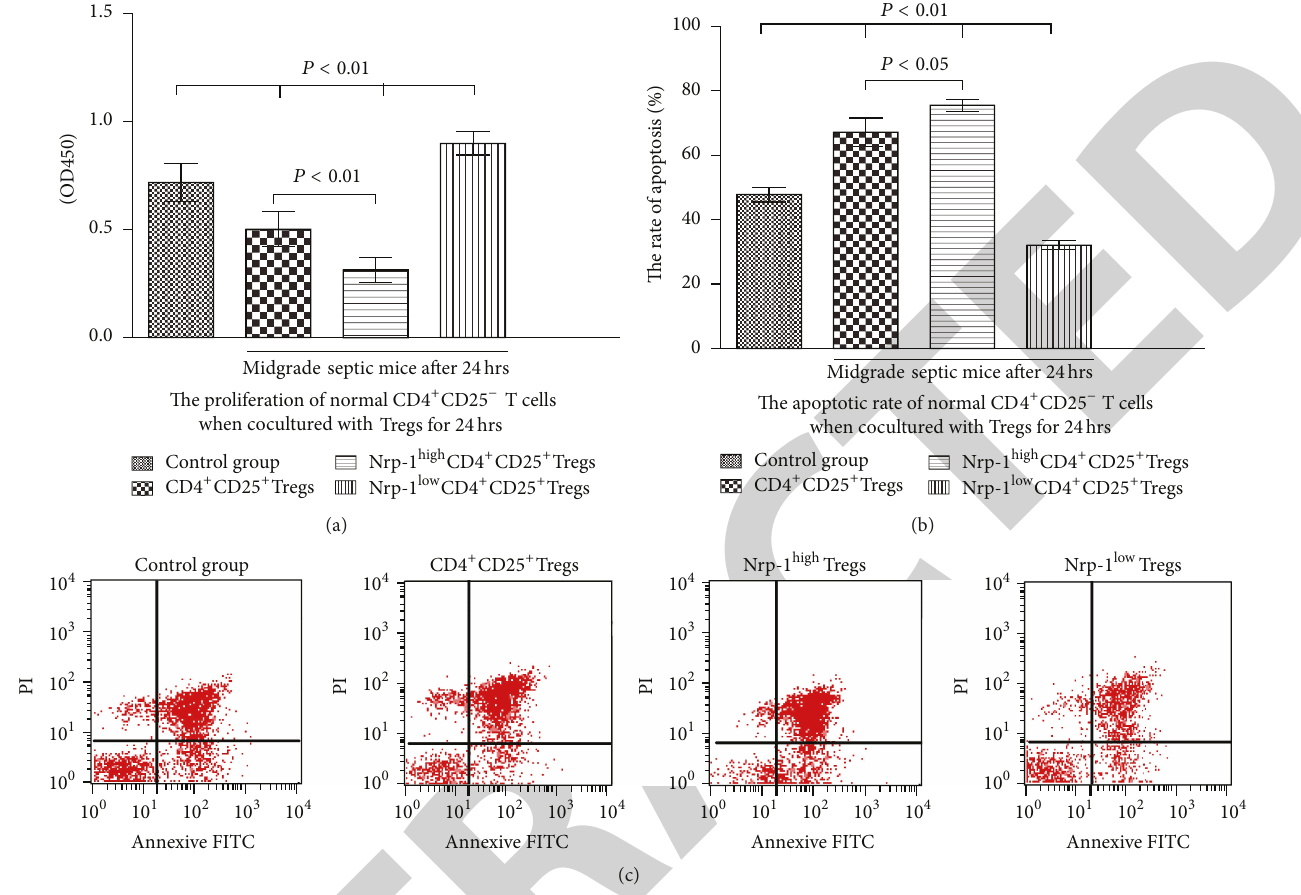
Figure 5: Nrp- 1 high CD4 + CD25 + Tregs showed the strong ability to inhibit the proliferation and increase the apoptosis of CD4 + CD25 − T cells. Three different subtype Tregs groups (CD4 + CD25 + Tregs, Nrp- 1 high CD4 + CD25 + Tregs, and Nrp- 1 low CD4 + CD25 + Tregs) were cocultured with CD4 + CD25 − T cells for 24 hours in a ratio of 1:1; the proliferative ability of CD4 + CD25 − T cells (a) and apoptotic rate of CD4 + CD25 − T cells ((b), (c)) were determined. Data was represented as mean ± standard deviation (SD) and analyzed by SPSS 17.0 software with a one-way ANOVA, 𝑛 = 4 per group ( 𝑃 < 0.05 or 𝑃 < 0.01